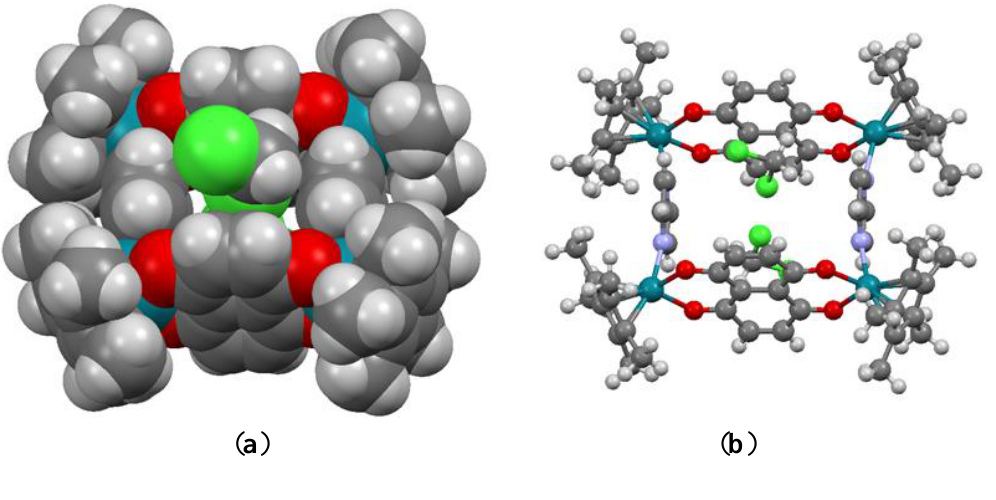
Figure 6. Space-filling ( a ) and ball-and-stick models ( b ) of metalla-rectangle 3 showing the two molecules of dichloromethane sitting on both sides of the cavity.